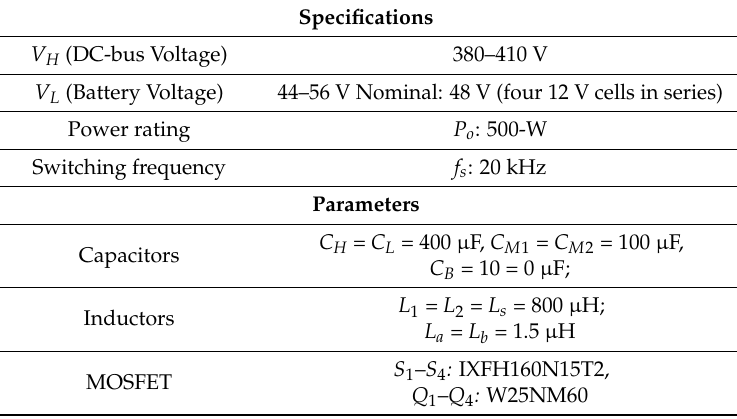
Table 1. Specifications and parameters of the realized prototype.